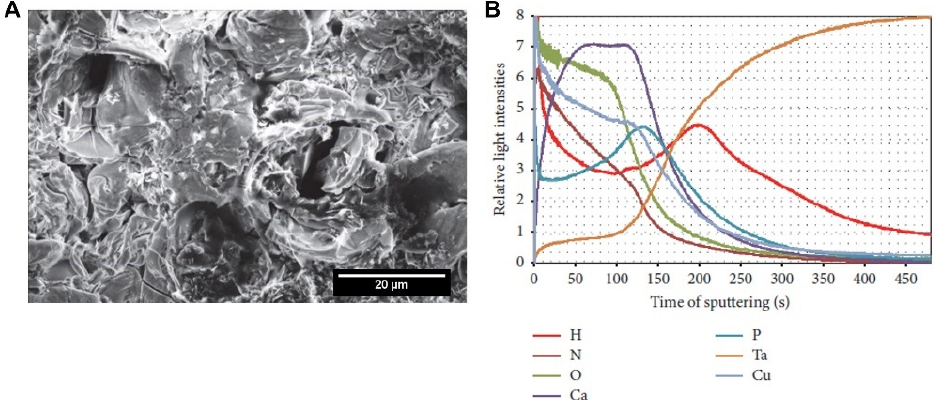
Figure 9. ( A ) Surface morphology of MAO-treated Ta surface. ( B ) Relative light intensities of tantalum, phosphorus, calcium, copper, oxygen, and nitrogen anodic coating formed on tantalum obtained by the GDOES method. Adapted from Ref. [66].